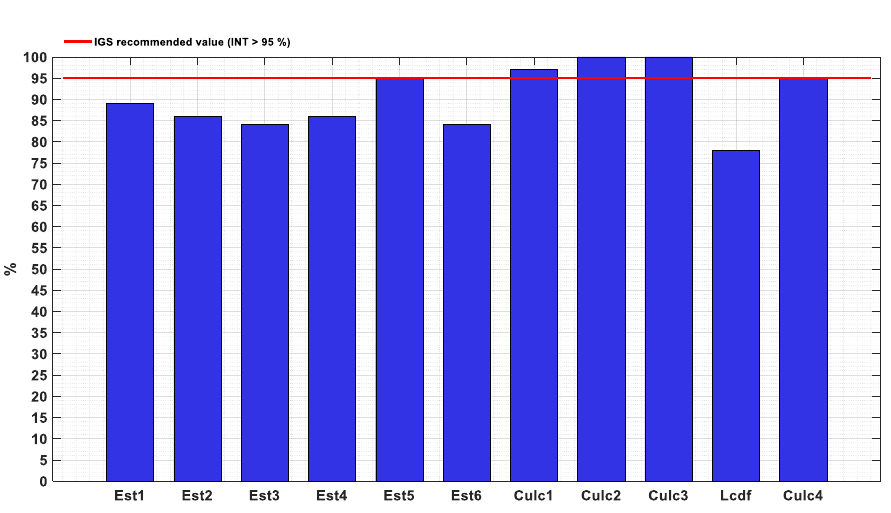
Figure 5. Integrity. Red line: 95% of integrity [36].